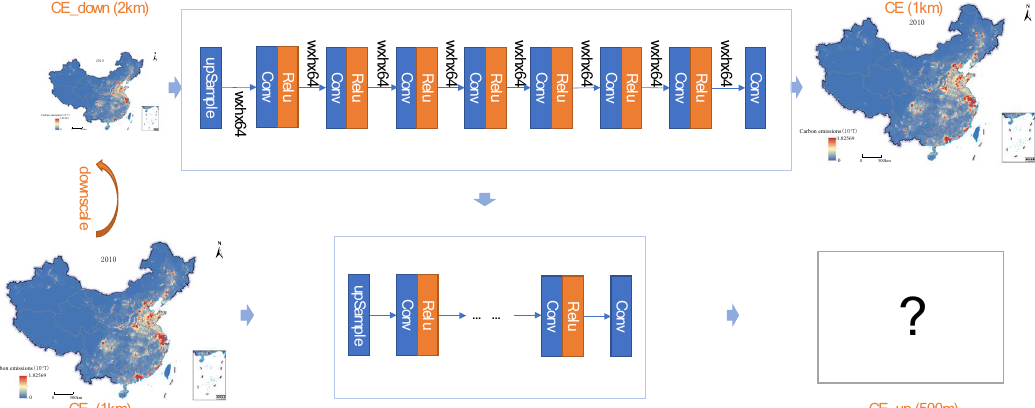
Figure 8. Zero-Shot Super-Resolution model. This map is based on the standard map No. GS(2019) 1823 downloaded from the Ministry of Natural Resources Standard Map Service website. The base map is